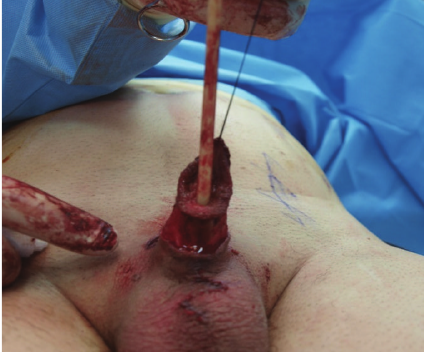
Figure 1: Short penile stump.